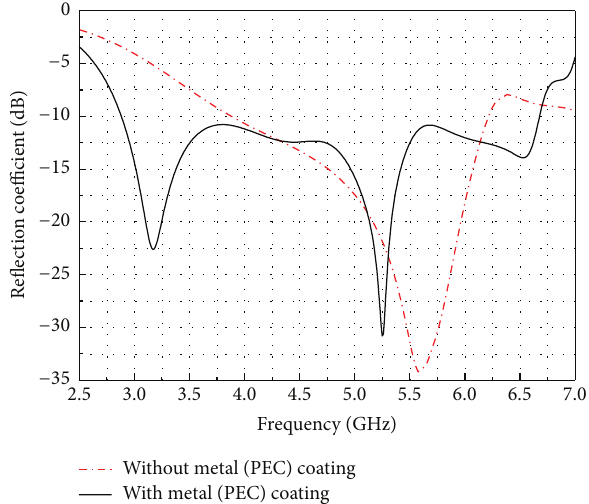
Figure 2: Effect of the metal coating on the impedance matching characteristic.